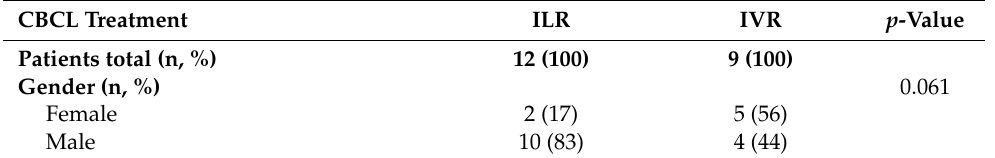
Table 1. Patient characteristics of the included patients with indolent CBCL receiving either ILR or